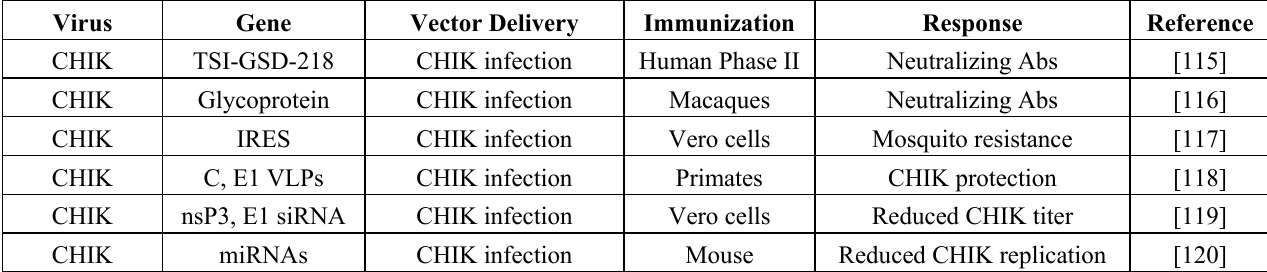
Table 4. Alphavirus-based vaccine development against